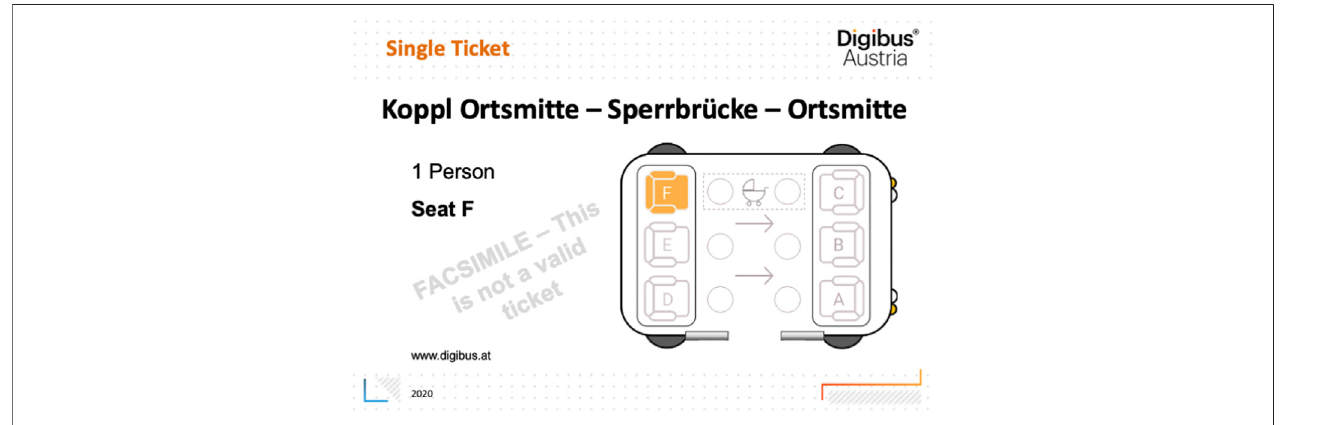
FIGURE 12 | Study 3: The physical ticket that was handed out to the participants after completing the booking process in the app.